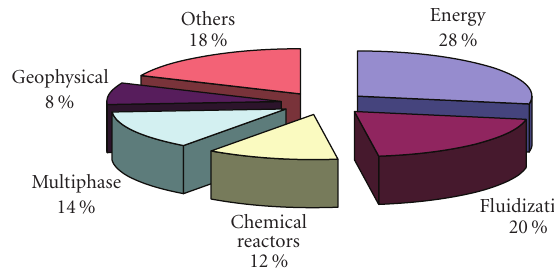
Figure 4: Di ff erent categories of MFIX